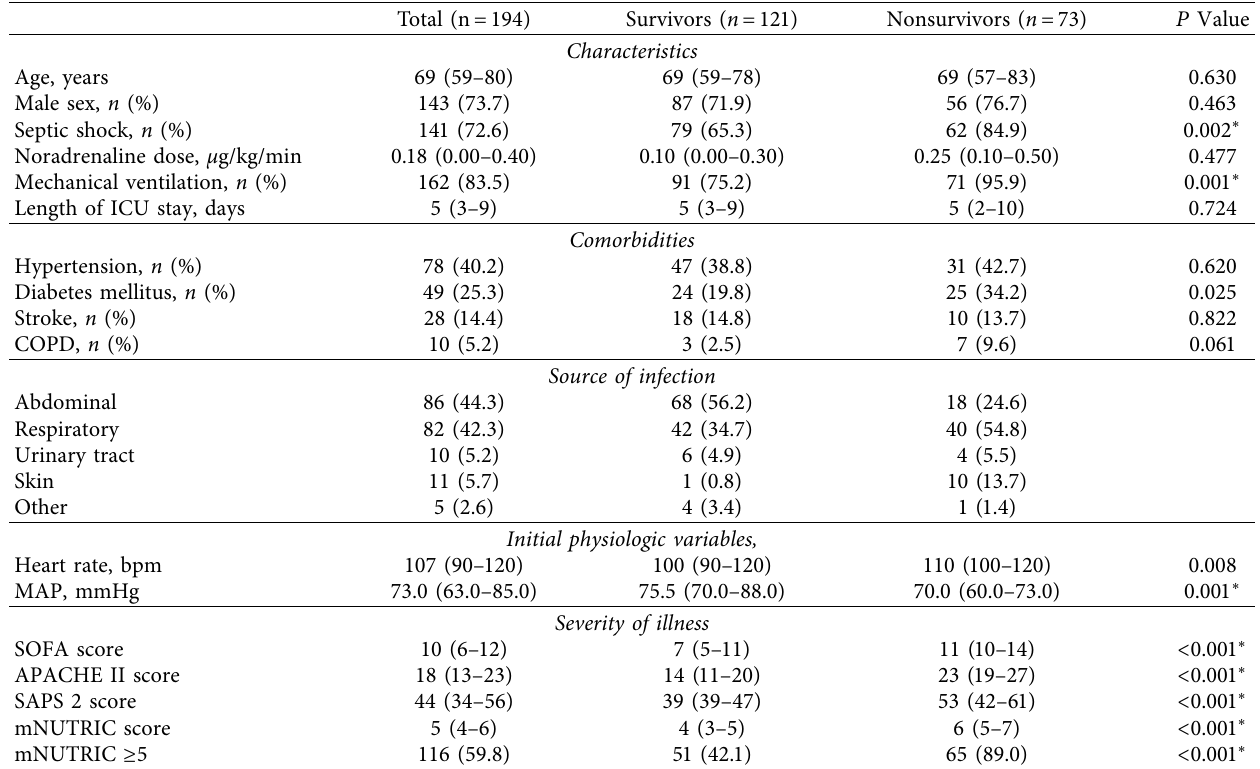
Table 1: Baseline clinical characteristics of patients.